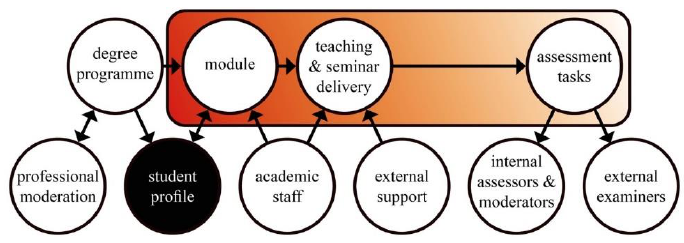
Figure 7. Process for mapping sector involvement at each stage of module design and delivery.